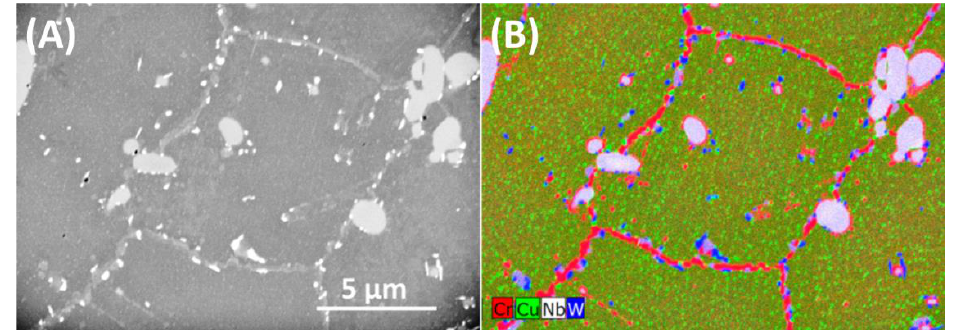
Figure 4. Microstructure of bulk material after oxidation at 700 °C for 5000 h: ( A ) SEM-SE image, ( B ) SEM-EDS elemental map of selected elements.